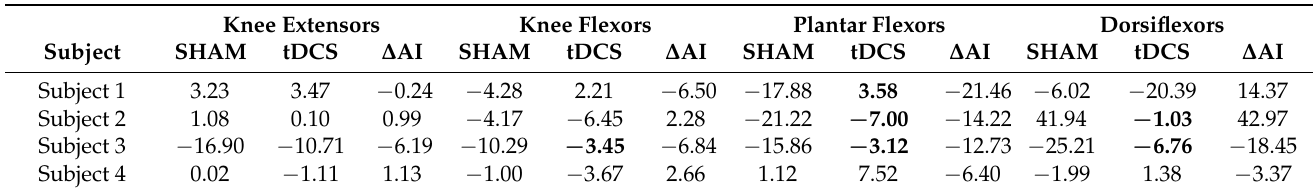
Table 3. Standardized uptake value (SUV) asymmetry indices (AIs in %) after SHAM and tDCS. Knee Extensors Knee Flexors Plantar Flexors